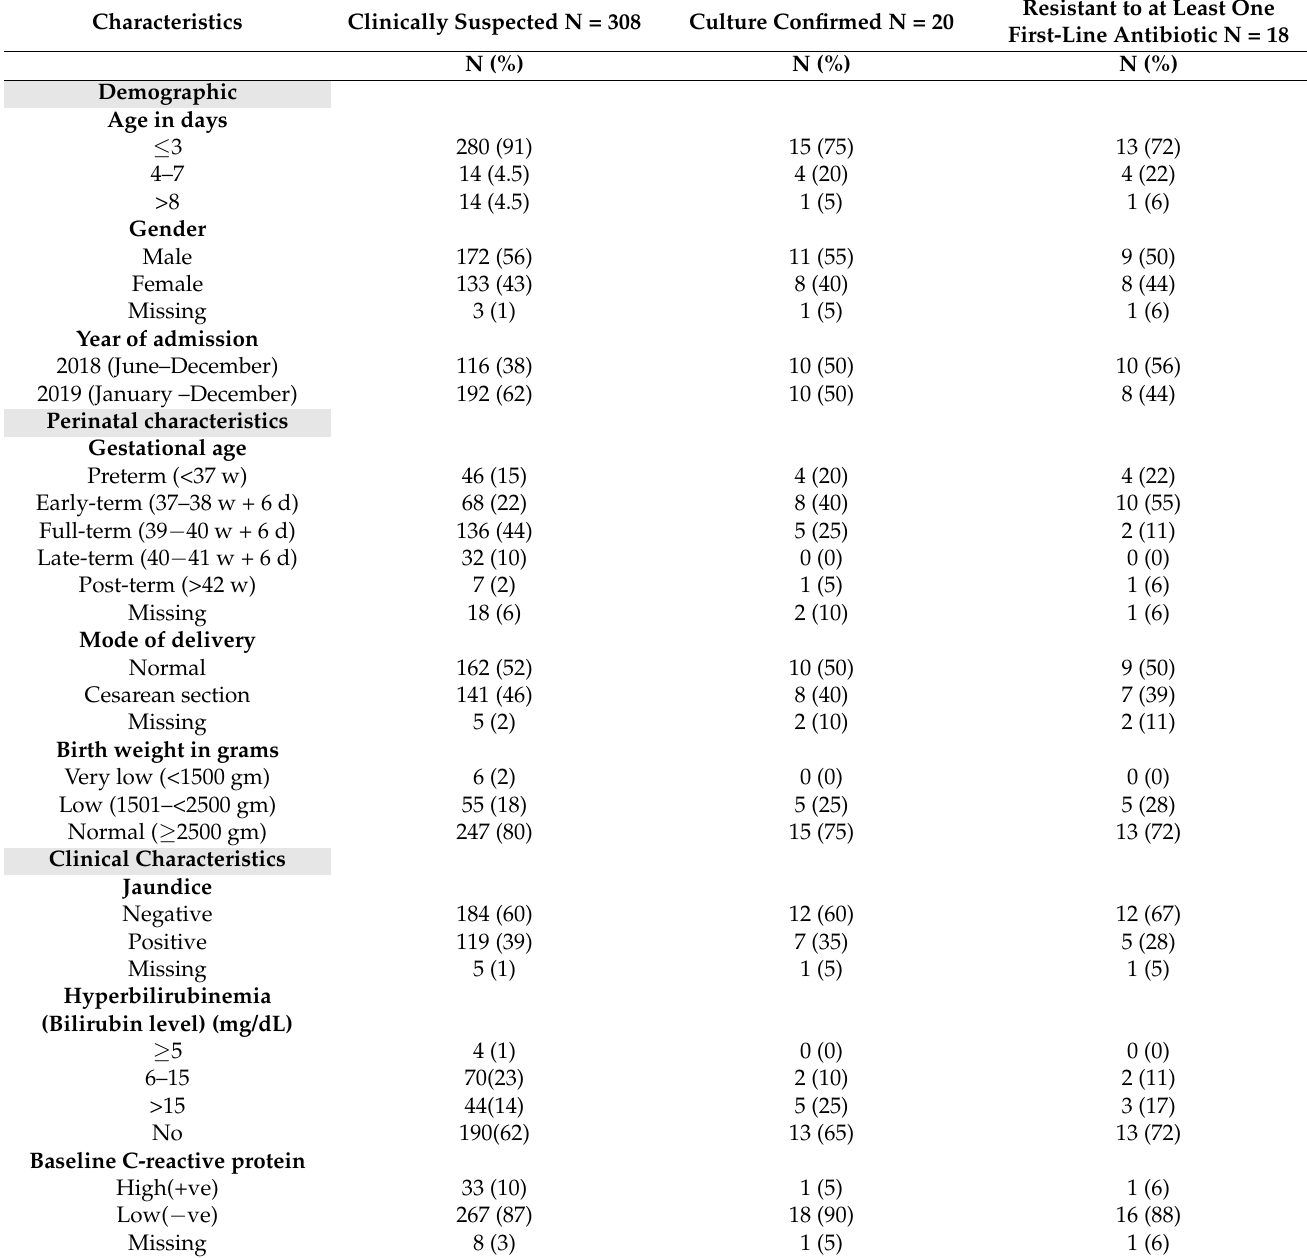
Table 1. Demographic, perinatal, and clinical characteristics of neonates with clinically suspected sepsis, culture-confirmed, and those with resistance to at least one first-line antibiotic admitted to NICU at KIST MCTH, Kathmandu Valley, Nepal during